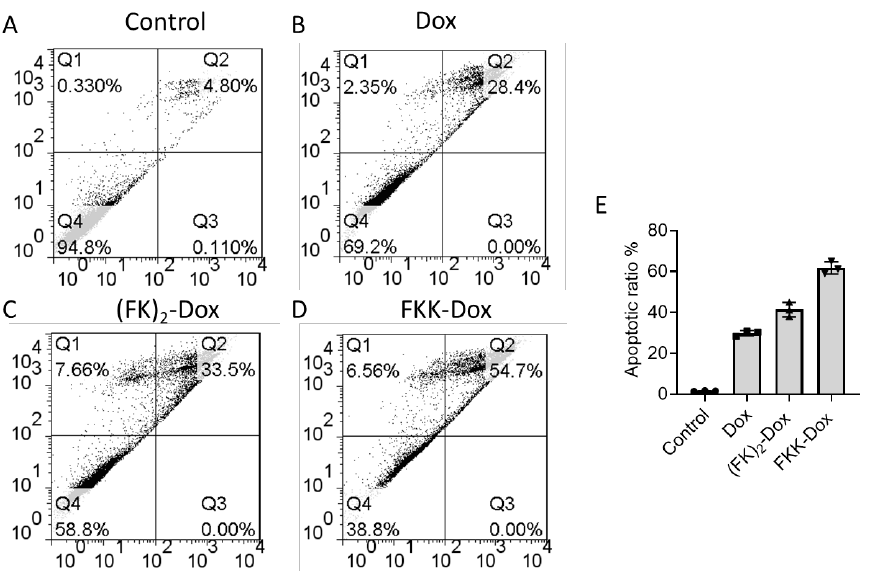
Figure 9. ( A – D ) Induction of apoptosis by di ff erent kinds of Dox species in Hela cells. Hela cells were treated with free-Dox (100 nM), (FK) 2 -Dox (100 nM of Dox) or FKK-Dox and analyzed 24 h after the treatment. Raw data for a representative experiment was shown. ( E ) The apoptotic cell ratio in di ff erent groups of cells after treated with free-Dox (100 nM), (FK) 2 -Dox (100 nM of Dox) or FKK-Dox. Three independent replications were performed. Error bars are